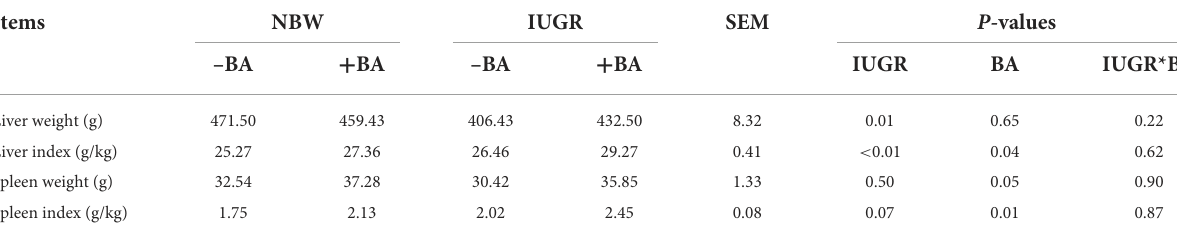
TABLE 1 Effects of dietary bile acid (BA) supplementation on liver and spleen indices in weaned piglets with NBW and IUGR.